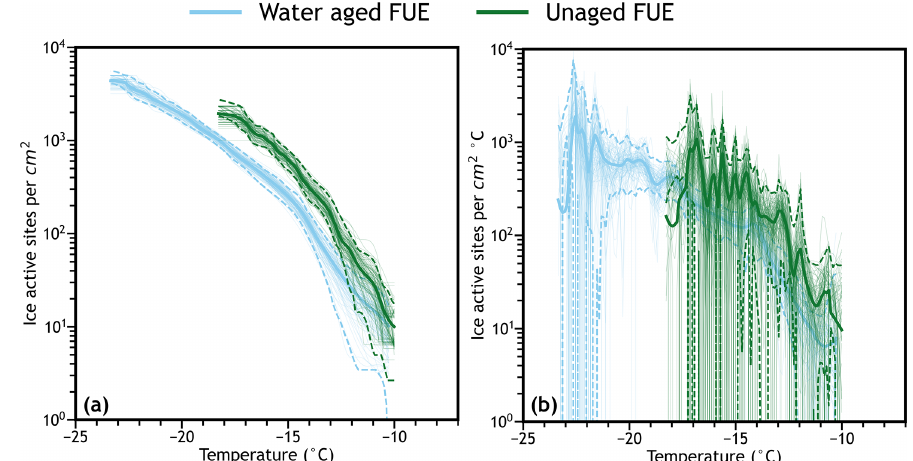
Figure 3. Interpolated combined data (bold line), interpolated 2.5th and 97.5th quantiles (dashed lines), and interpolated individual simu- lations (faint lines; N = 100) of the (a) cumulative n s and (b) differential n s spectrum for each set of combined ash data from Fig. 1. The simulated data (faint lines) using empirical bootstrapping provide a realistic estimate of the distribution of how the spectra could vary based on stochasticity, variations in the individual droplet freezing experiments comprising the combined experimental spectrum, and other factors contributing to experimental